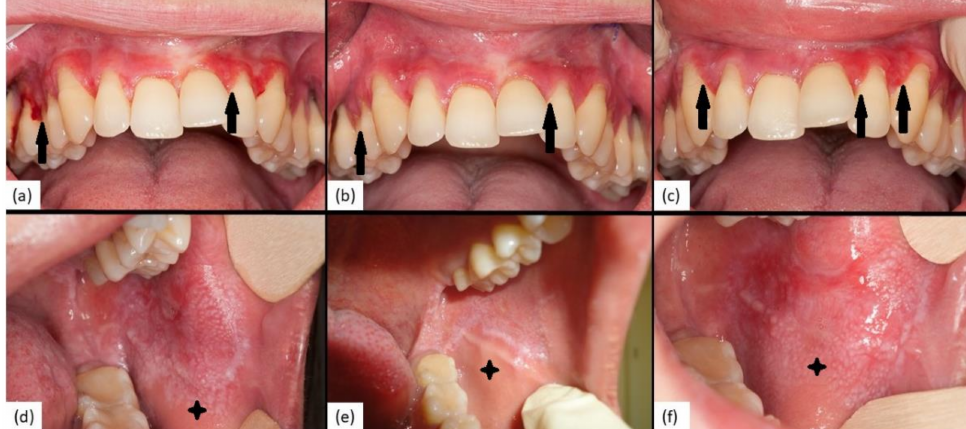
Figure 4. Clinical pictures of patient 2 (panel ( a – c )) and patient 8 (panel ( d – f )) at baseline (T0), after 4 weeks of CSA (T1) and after another 4 weeks without therapy (T2). PGA of patient 2 was 2 at T0 ( a ), 0.5 at T1 ( b ) and 1 at T2 ( c ) (arrows indicate affected and improved areas). PGA of patient 8 was 3 at T0 ( d ), 1 at T1 ( e ) and 2.5 at T2 ( f ) (asterisk indicates affected and improved